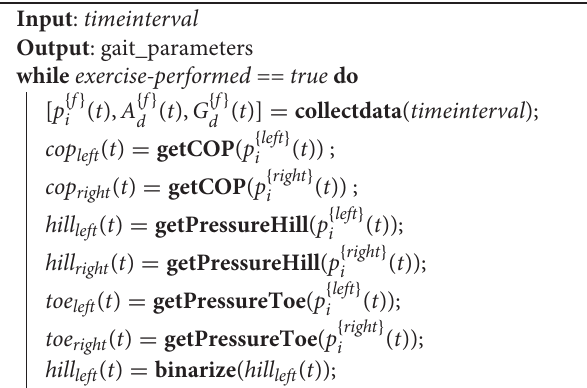
Algorithm 3: Gait parameters